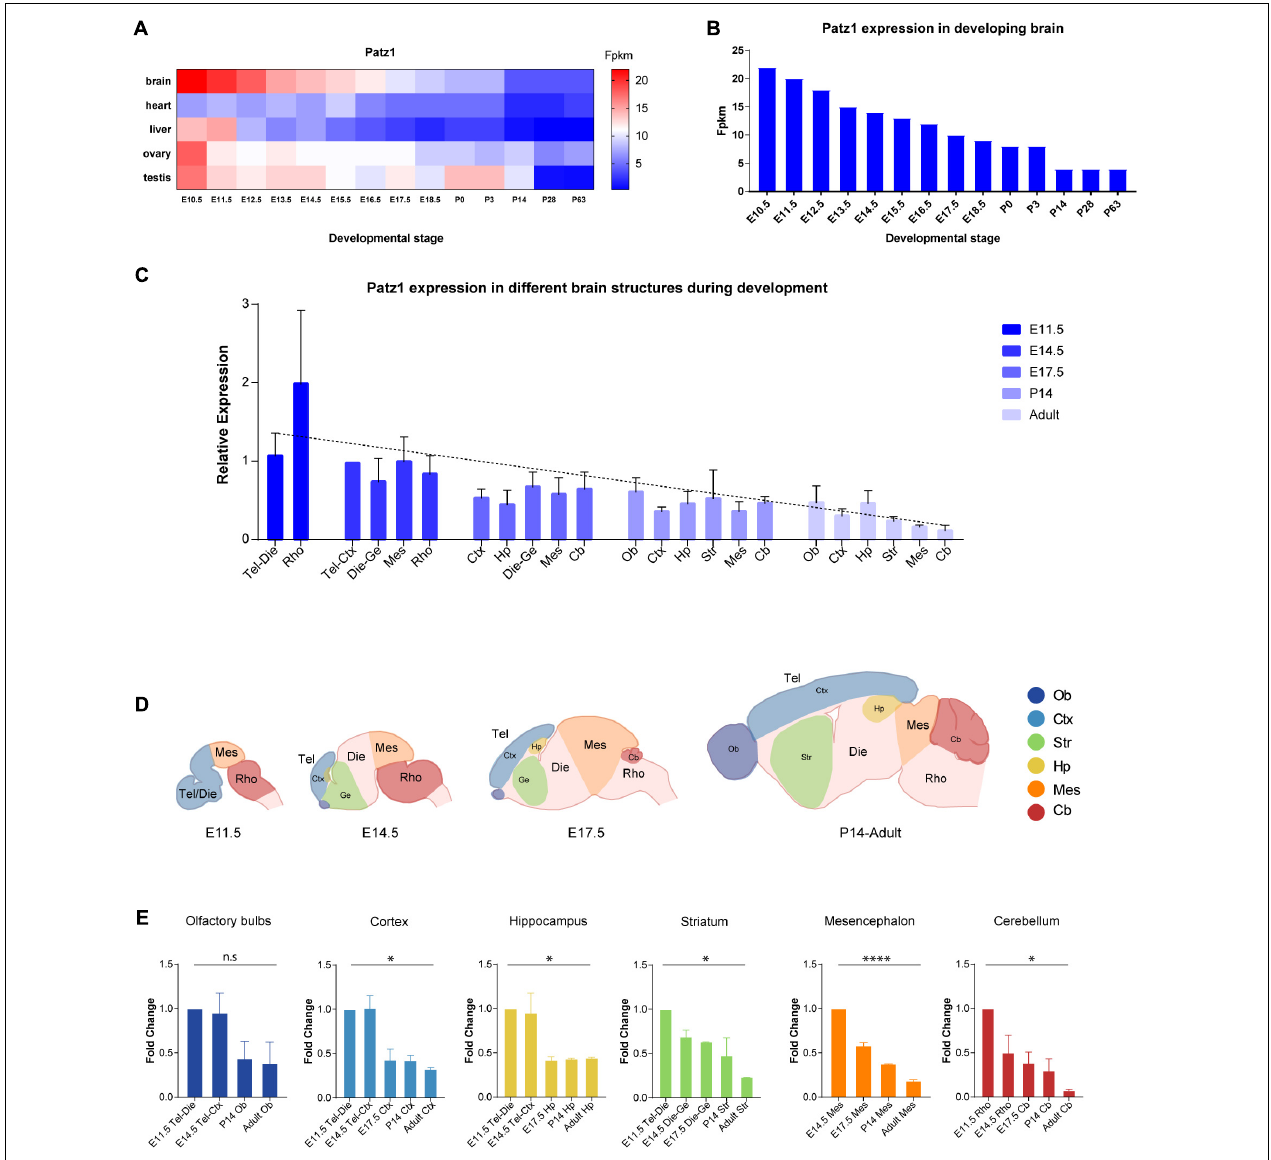
FIGURE 1 | Patz1 expression in embryonic and postnatal tissues and brain structures. (A) Heatmap showing Patz1 expression from EMBL-EBI Expression Atlas in the murine brain, heart, liver, testis, and ovary across development. (B) Bar plot highlighting Patz1 expression levels in the brain during development from EMBL-EBI Expression Atlas. (C) Bar plot showing the relative expression of Patz1 (2 − (cid:49)(cid:49) Ct ) in different embryonic, postnatal and adult brain regions, using the E14.5 Tel-Die sample as calibrator. (D) Schematic representation of brain structures at different developmental stages. (E) Bar plots showing Patz1 fold change expression relative to E11.5 or E14.5 control sample (2 − (cid:49)(cid:49) Ct ) in the different microdissected brain structures. Tel, Telencephalon; Die, Diencephalon; Mes, Mesencephalon; Rho, Rhombencephalon; Ob, Olfactory bulbs; Ctx; Cerebral Cortex; Hp, Hippocampus; Ge, Ganglionic eminence; Cb, Cerebellum; Str, Striatum. Graphs are represented as mean values ± SD and all the significant differences are indicated by asterisks. ∗ p < 0.05; ∗∗∗∗ p < 0.0001, as assessed by ANOVA. n.s. = not